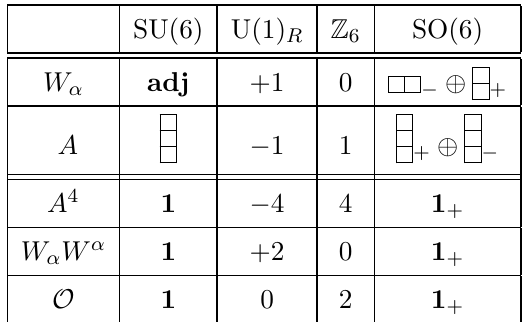
Table 13 . Quantum number of fields in the SU(6) theory with rank-three anti-symmetric tensor A . The last row is the operator O = Tr ( T a AA ) Tr ( T a W α W α ) that acquires an expectation value and breaks Z to Z . 6 2